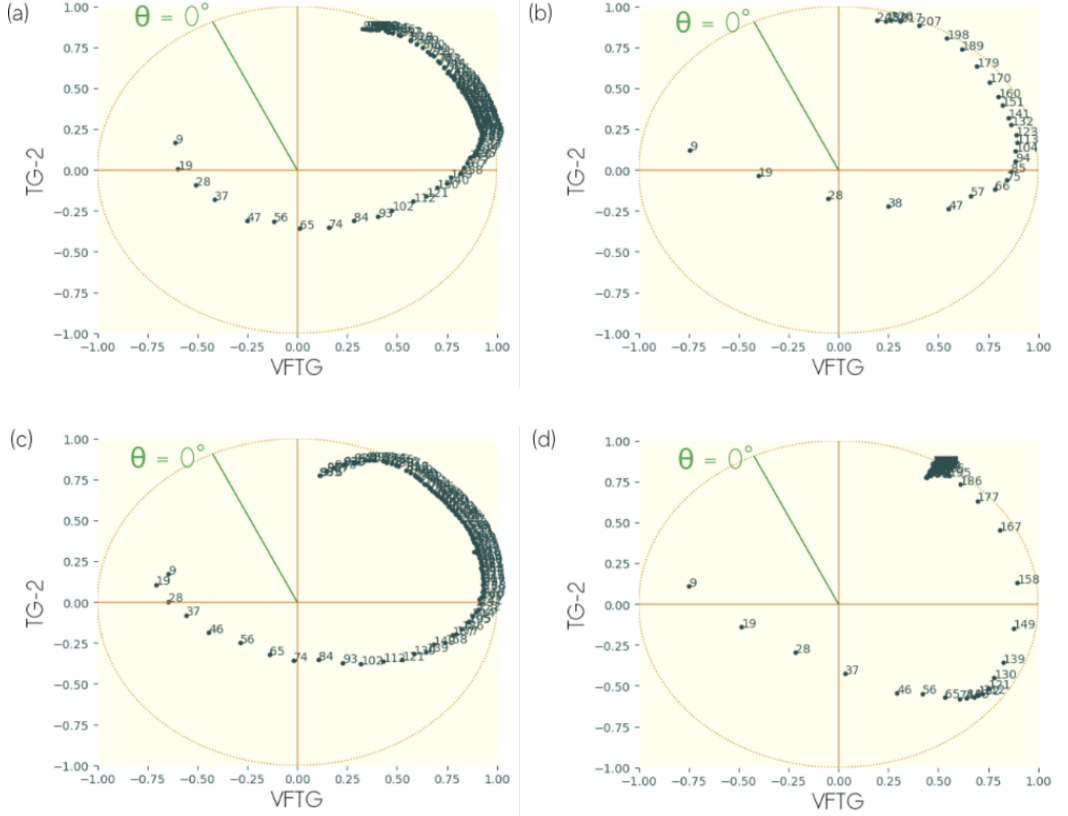
Figure A2. Correlation between spatial frequencies (expressed in cycles.km − 1 ) and Vegetation Fragmentation Gradient Texture (VFTG) and Canopy Grain Gradient Texture (TG-2) derived from ( a ) NDVI band of airborne imagery, ( b ) NDVI band of Pléiades imagery, ( c ) panchromatic band of Pléiades imagery and ( d ) fusion derived NDVI of Pléiades imagery; after optimal rotation of 30 ◦ original principal component 1 and 2 for ( a – c ) and 60 ◦ for ( d